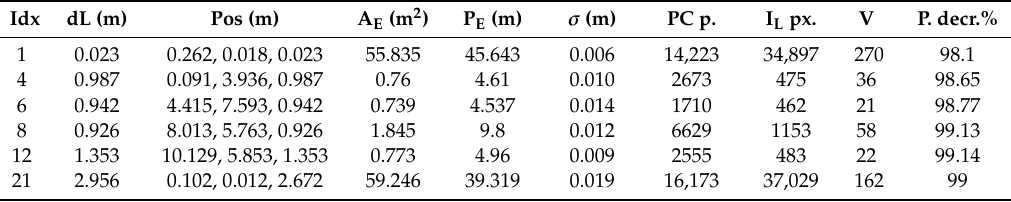
Table 4. Detected planes with the physical description in the Z-axis.